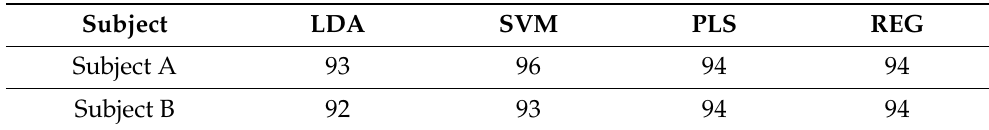
Table 3. Asymmetrical pairs between happy and pleased emotions.